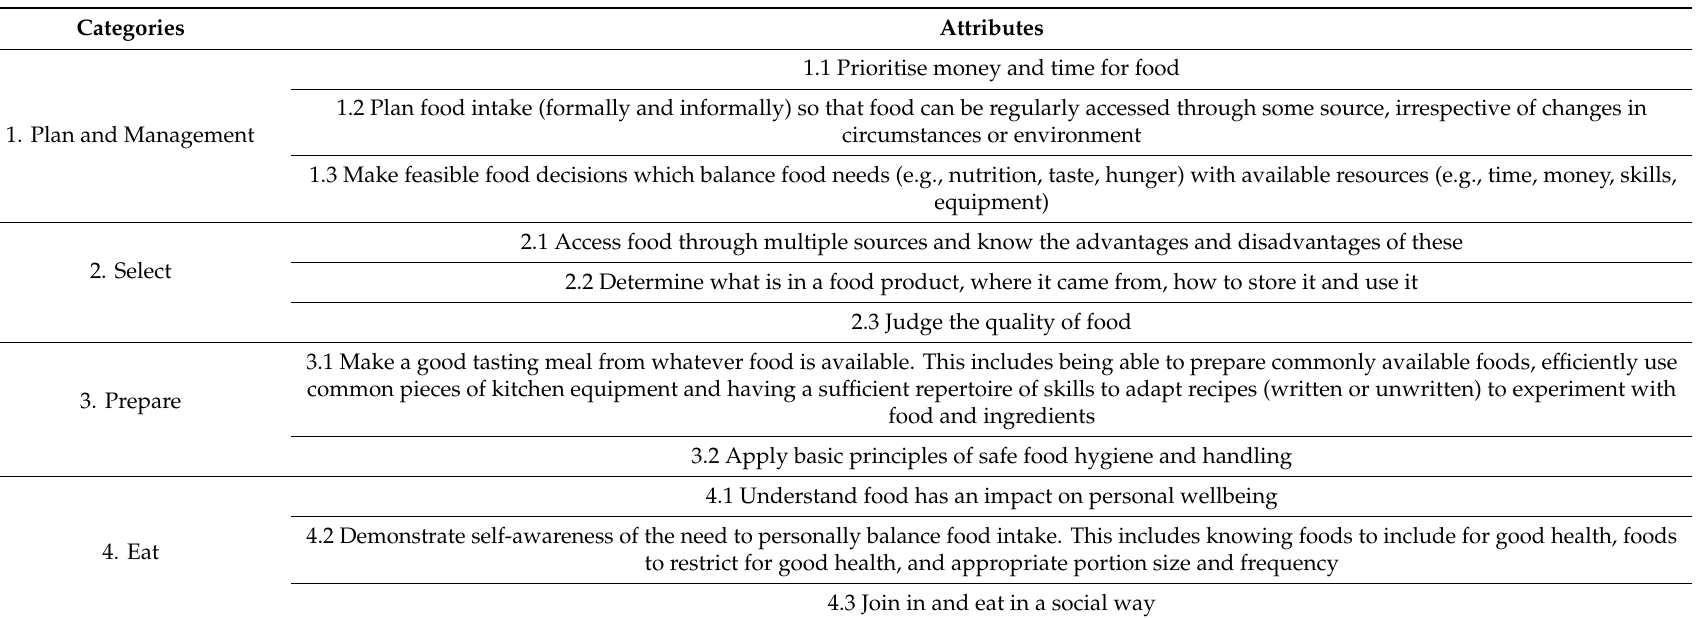
Table A1. Framework A